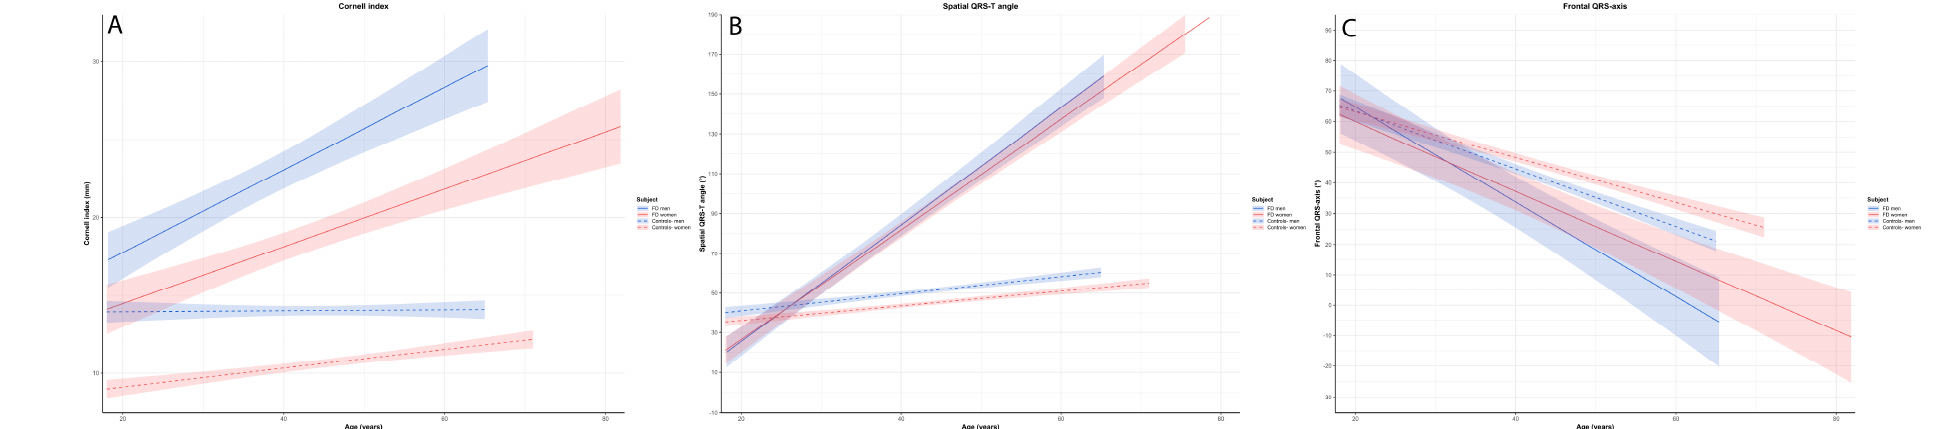
Figure 2. Based on the GLM, the estimated effect plots with the 95%-CI of ( A ) Cornell index, ( B ) Spatial QRS-T angle and ( C ) Frontal QRS-axis for each study participants subgroup.